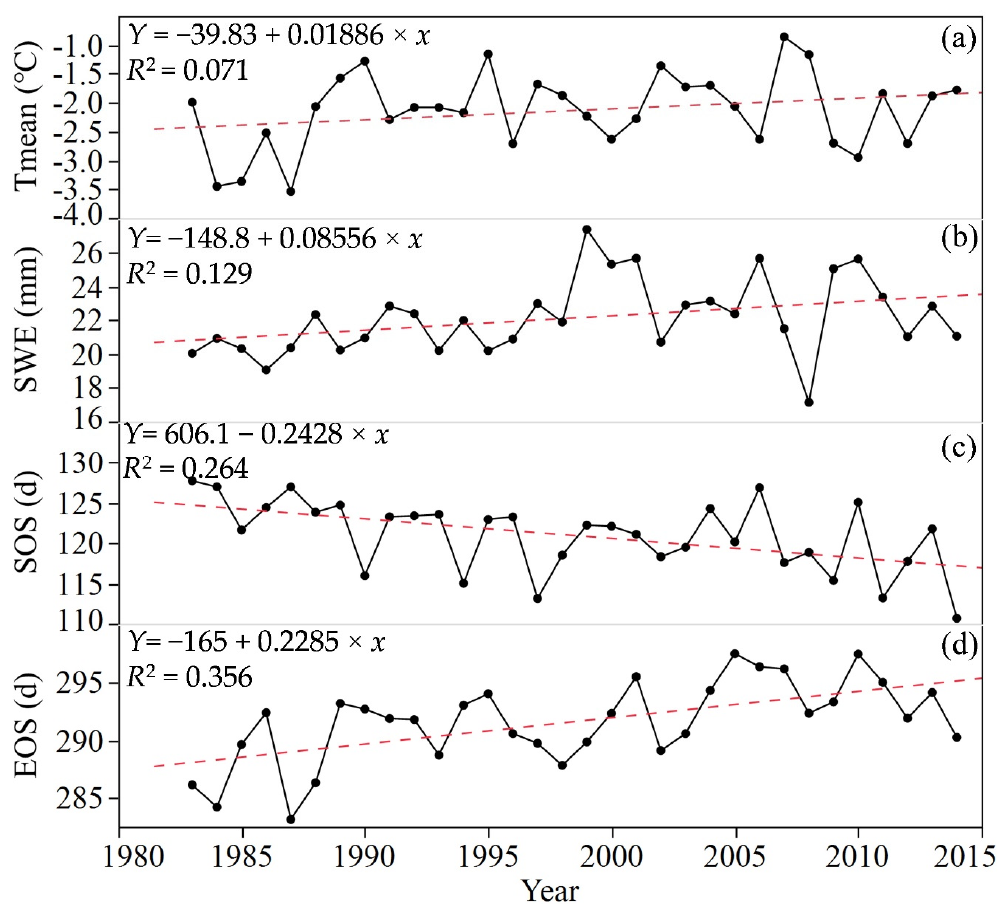
Figure 4. Trends and temporal variations of annual mean temperature ( a ), annual mean snow water equivalent ( b ), SOS ( c ) and EOS ( d ) for forest vegetation in the China–Mongolia–Russia International Economic Corridor between 1983 and 2014.